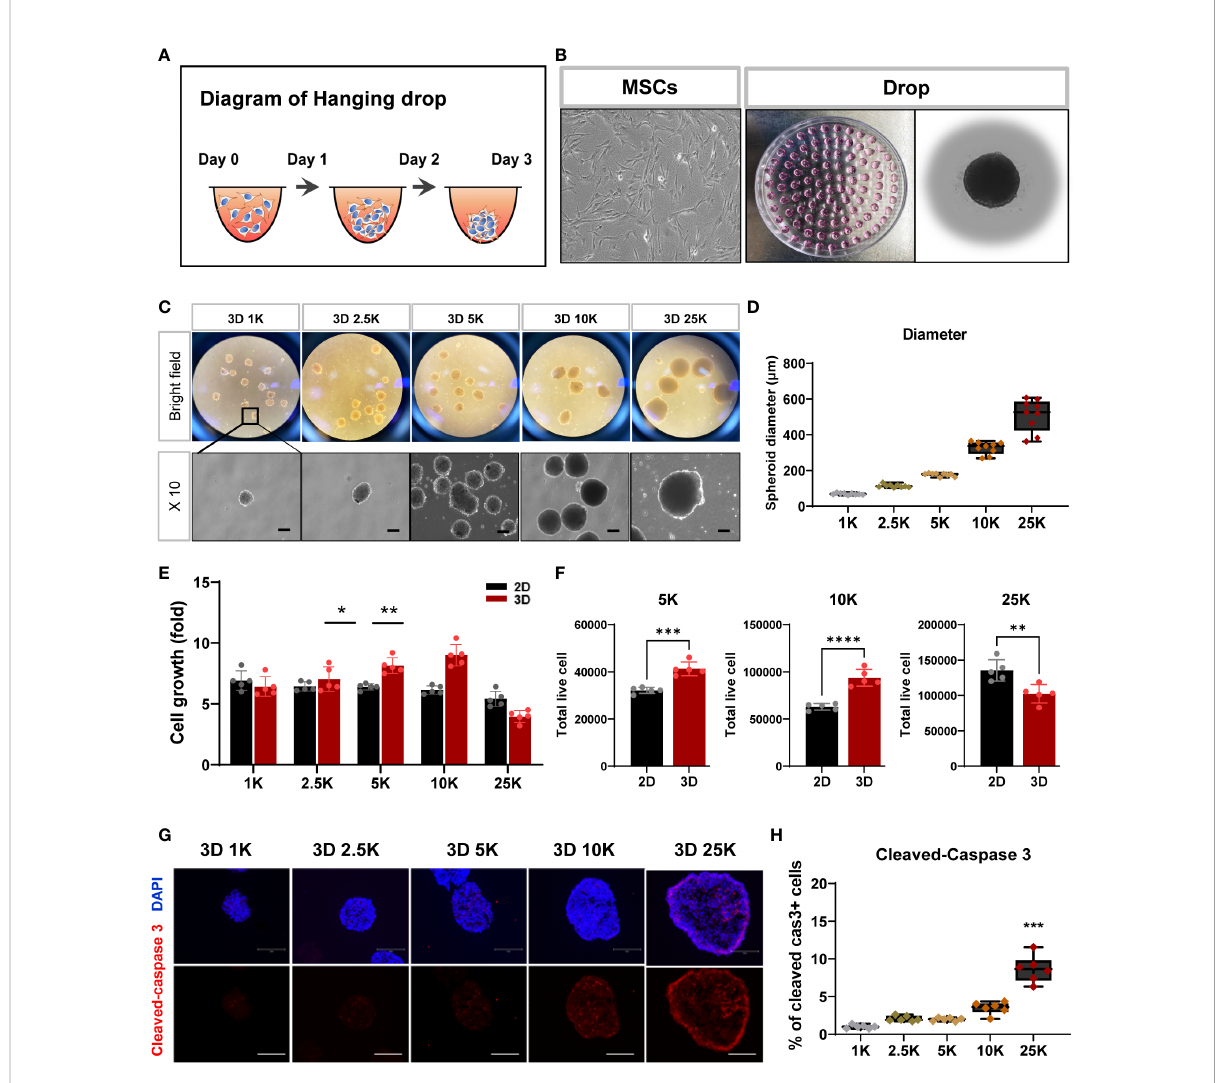
FIGURE 3 Structural and cell viability of tonsil-derived MSC spheroids (3D) depending on cell densities. (A, B) Suspension culture of MSC spheroids using hanging drop method. (A) Schematic diagram of hanging drop. (B) Bright- fi eld images for tonsil-derived MSCs (TMSCs) and drops in a petri dish. (C) Morphological features of the spheroids formed at fi ve different cell densities. Spheroids incubated for 3 days and then collected them from the petti dish. Scale bar: 100 m m. (D) The diameter of spheroids ( m m). (E) Fold change of spheroid cell growth. (F) The number of live cells in a density of 5000, 10000 and 250000 cell spheroids. Spheroids were dissociated into single cells and counted the total viable cells by trypan blue assay. (G) Immuno fl uorescence staining of cleaved-caspase 3 positive cell (Red) with DAPI (Blue) according to spheroids. Scale bar: 100 m m. (H) Quanti fi cation of the expression of cleaved-caspase 3. The high-density spheroid was increased the cleaved-caspase positive cells compare to smaller spheroids. Data are presented as mean ± SEM. Statistical signi fi cance for spheroid diameters, spheroid cell growth and % of